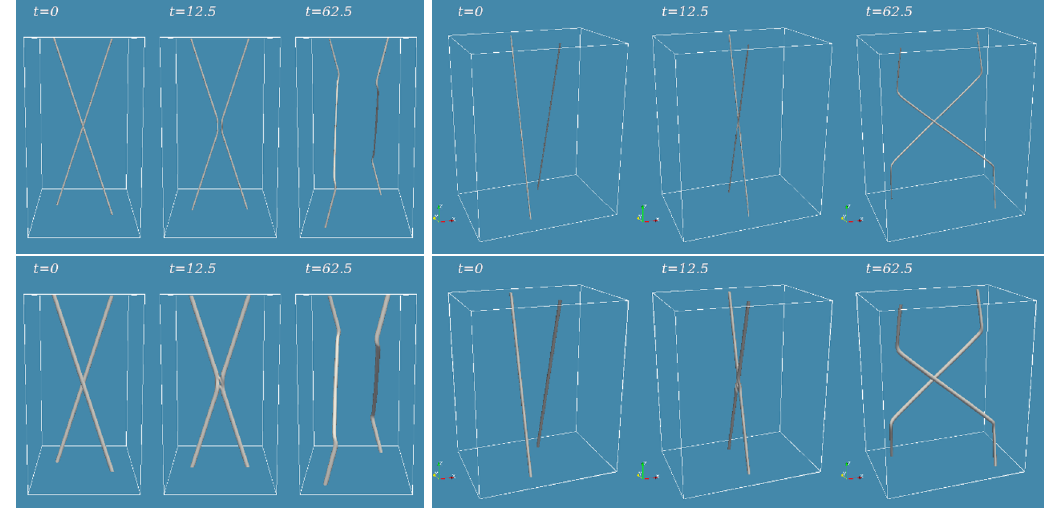
Figure 1 . Collision between the compensated strings with ( n 1 ; n 2 ) = (1 ; 2). The upper (lower) panels show the isosurface with j (cid:30) 1 j = (cid:17) 1 = 2 ( j (cid:30) 2 j = (cid:17) 2 = 2). For each panel, we also show the same snapshot from a di(cid:11)erent view (left and right).